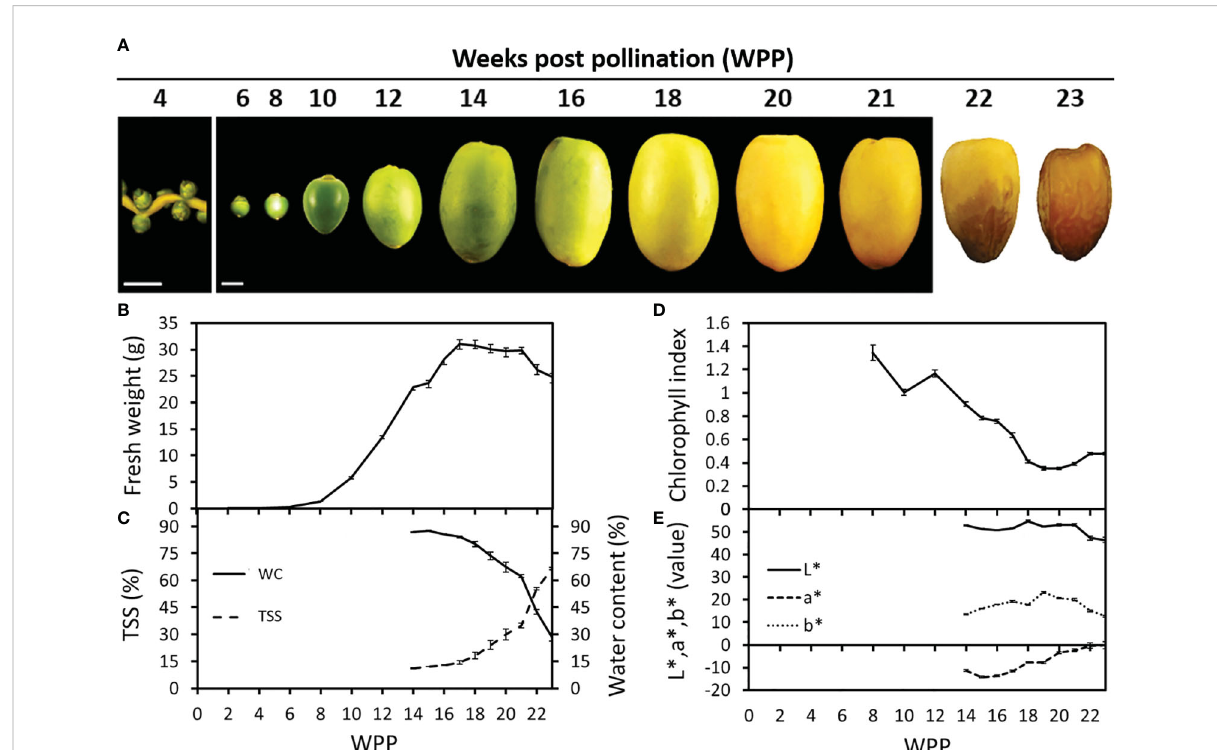
FIGURE 1 Date palm fruit development. Representative fruits were sampled and photographed along the course of fruit development (Gro fi t 2017). Numbers indicate weeks post-pollination ( WPP; A) . Fruit development was characterized through quanti fi cation of (B) fruit fresh-weight, (C) total soluble solids (TSS; %) and water content (WC; %), (D) chlorophyll relative fl uorescence and (E) L*a*b* color space parameters. Error bars indicate standard error. Scale bar: 1 cm. The number of fruits measured at each time point was (B, D, E) n=18 or (C)